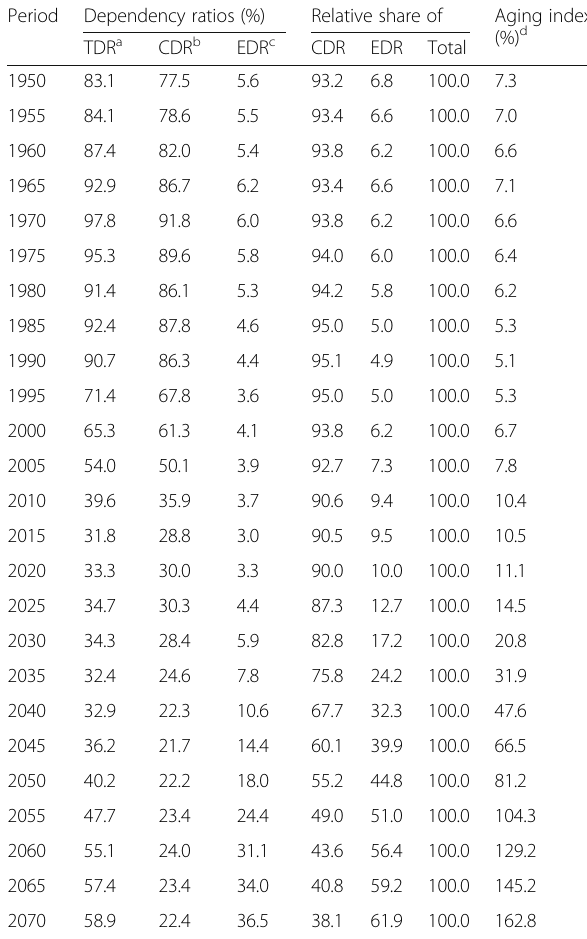
Table 3 Dependency ratios, relative share of child and elderly dependency ratio, and aging index in Oman, 1950 – 2070 Period Dependency ratios (%) Relative share